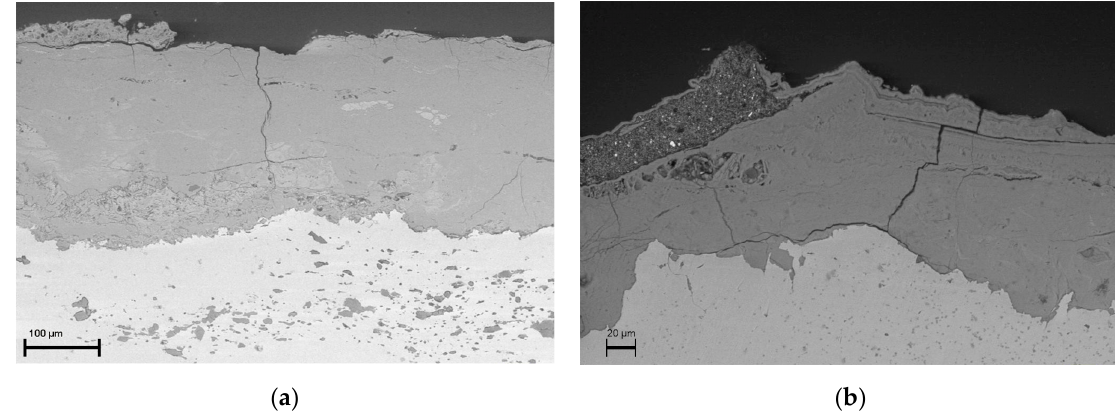
Figure 7. SEM images of Samples 44 ( a ) and 87 ( b ).